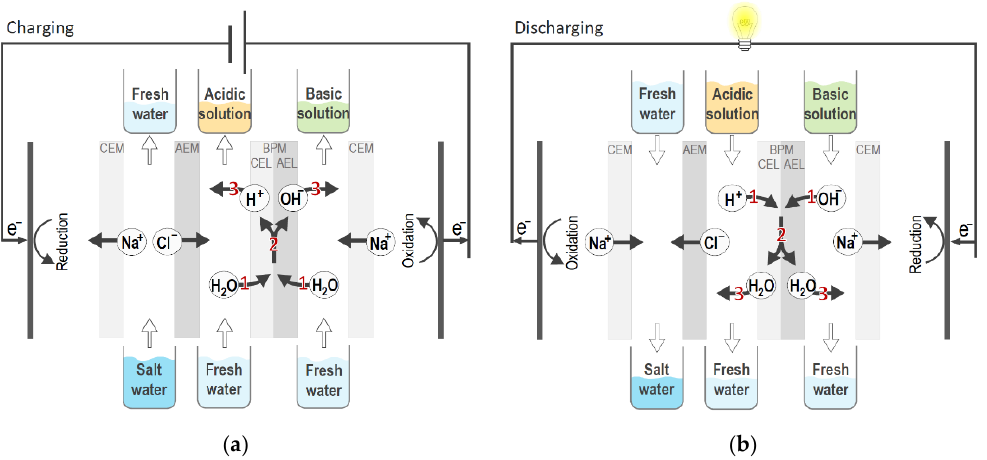
Figure 2. Schematic principle of the acid–base battery during ( a ) charging mode (bipolar membrane electrodialysis, BMED) and ( b ) discharging mode (bipolar membrane reverse electrodialysis, BMRED). Adapted from Reference [25].